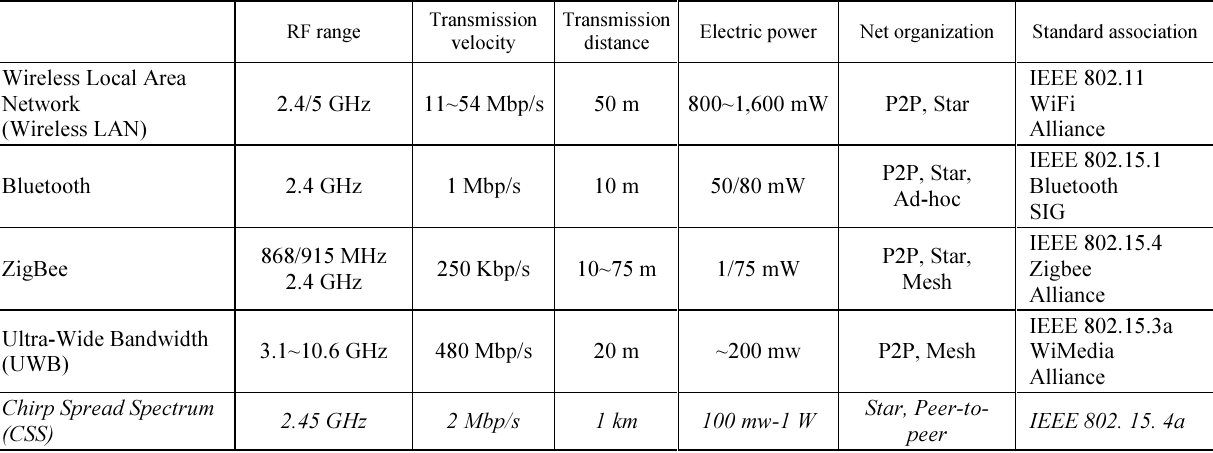
Table 4. Comparison of wireless networking